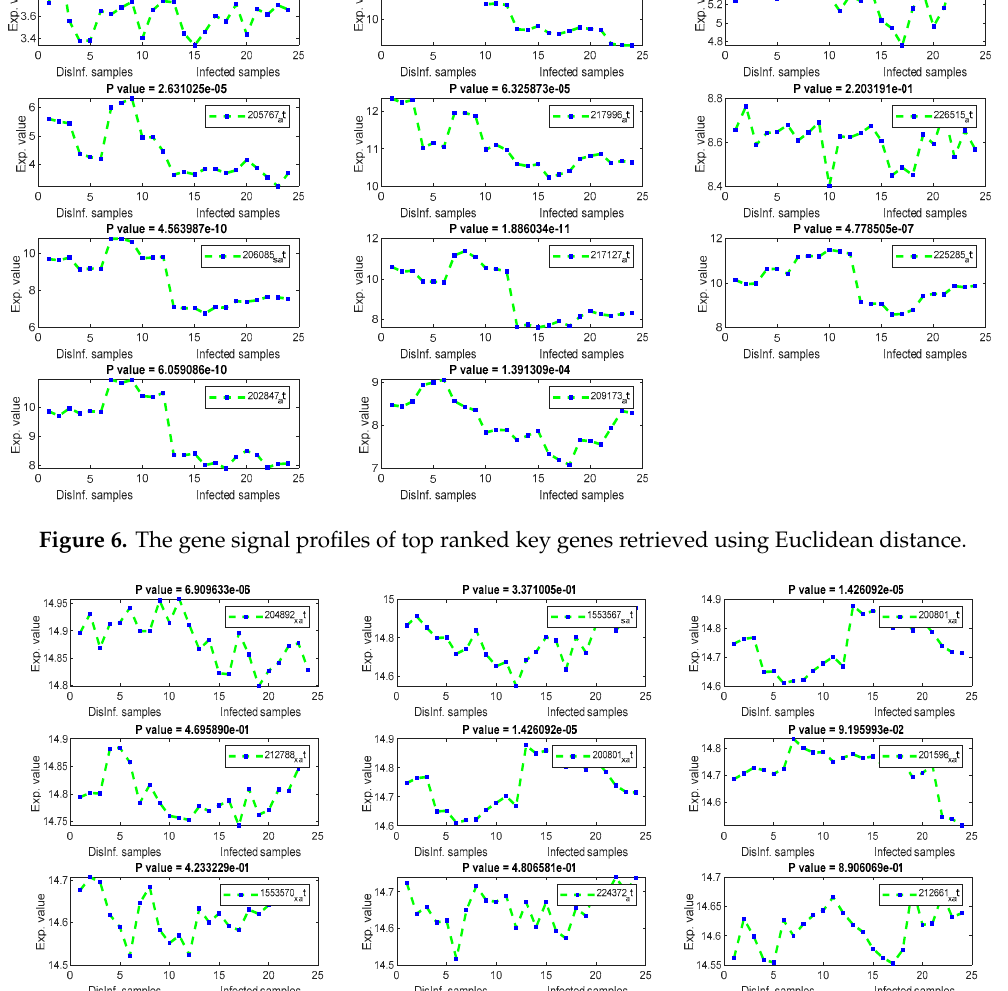
Figure 5. The gene signal profiles of top ranked key genes retrieved using Cosine and Pearson’s correlation.